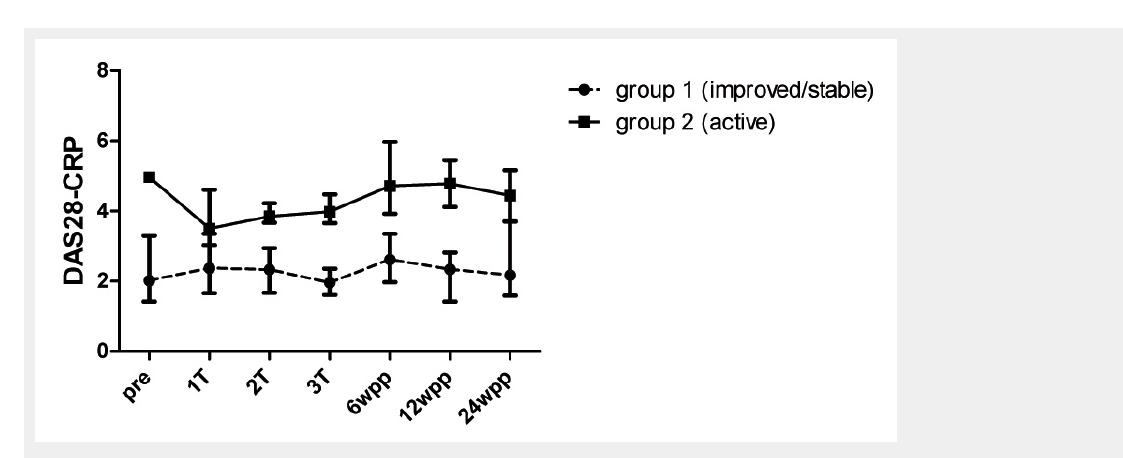
Figure 1 Disease activity of RA patients during and after pregnancy. Disease activity measured before (pre), once at each trimester (1T, 2T, 3T) and after pregnancy (6, 12 and 24 wpp: weeks postpartum) by the DAS28-CRP in 16 RA patients with low disease activity during pregnancy (group 1,dashed line) and in 6 RA patients with persistent active disease (group 2, black line). Values are medians with interquartile range.